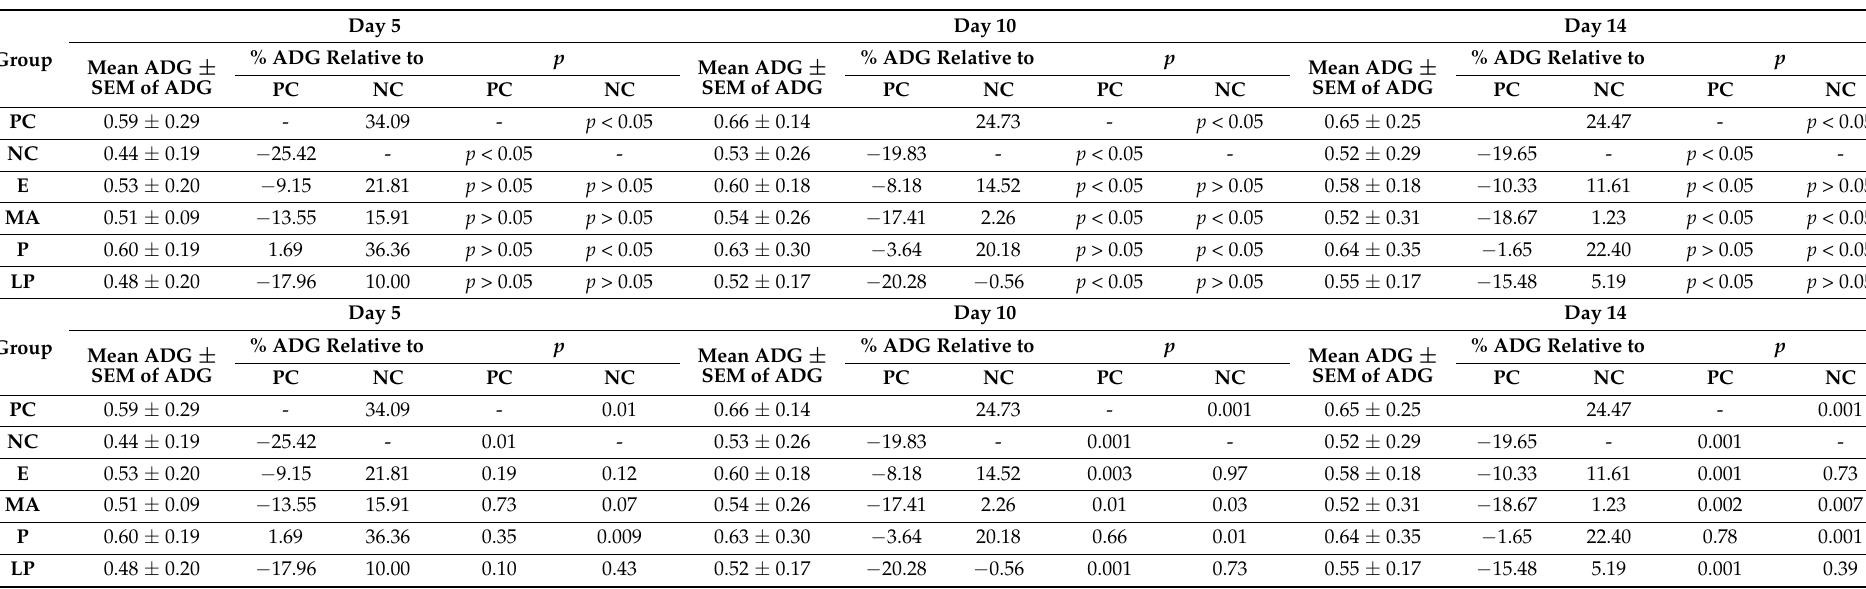
Table 2. Comparison of ADG in the different experimental groups of the mice. The p values are based on the Mann–Whitney U